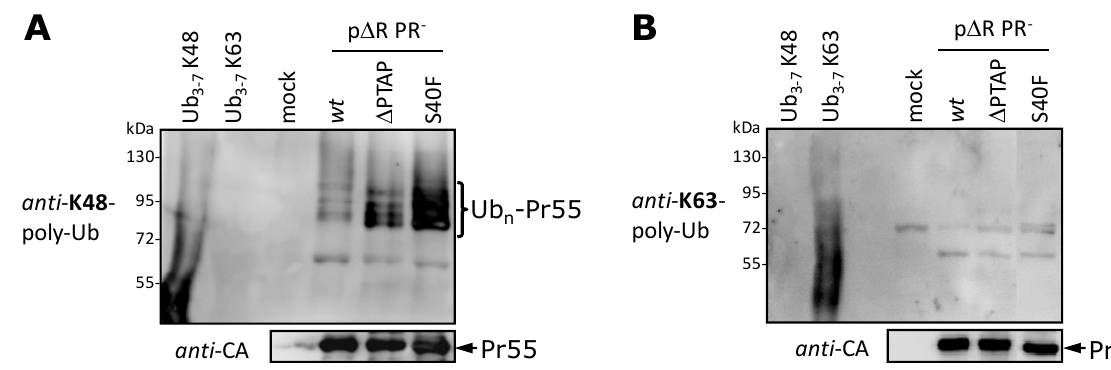
Figure 6. Gag is modified by K48-linked polyubiquitin. HeLa cells were transfected with p∆R PR − plasmids encoding wt Gag, or mutants thereof as indicated. 48 h post